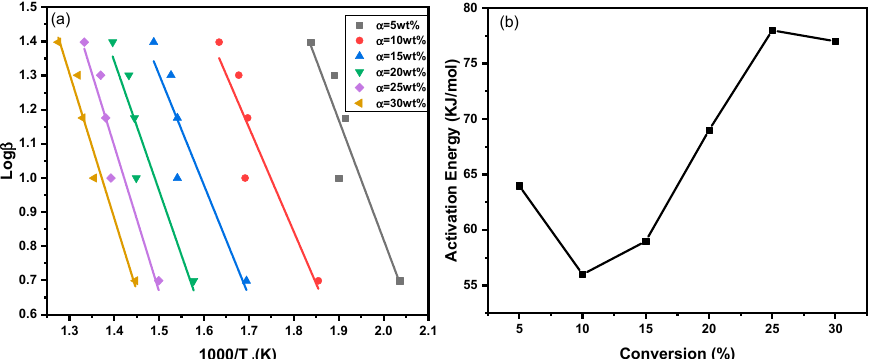
Figure 9. ( a ) Flynn-Wall-Ozawa isoconversion plot for calculation of activation energy of poly(CA- pdms-fu) and ( b ) Degradation activation energy as a function of the conversion of poly(CA-pdms- fu).